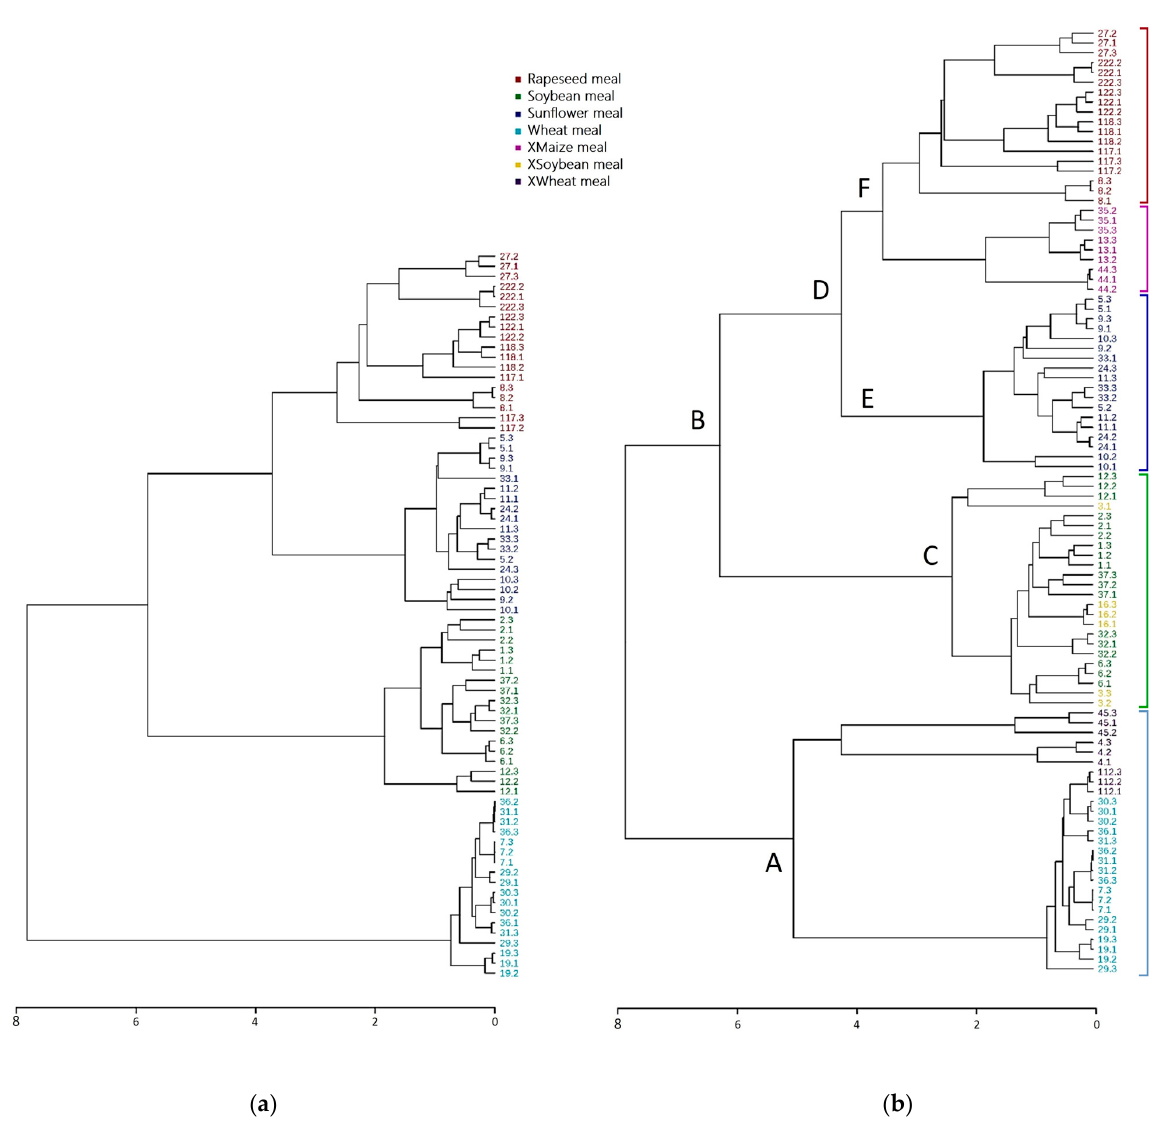
Figure 5. Hierarchical clustering analysis of the studied samples ( a ), with the presence of the additional ( b ) samples included in the present study. Samples marked with X before their names indicate additional meal samples of soya, wheat and maize.